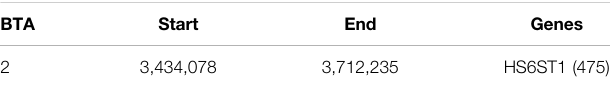
TABLE 2 | Chromosome (BTA) and start and end position (bp) of the imprinted QTL regions de fi ned for carcass weight, as well as the name of genes located withina0.5 Mbwindow ofeach region[distance (inKb) fromtheleadSNP ofeach region in parenthesis] a .